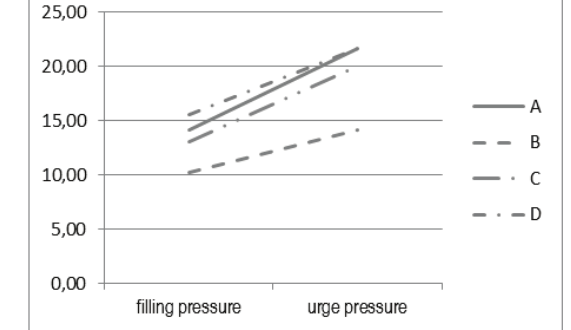
Figure 3: Comparison between sensitivity thresholds required to elicit a sensation of filling and defecation urgency in the four patient